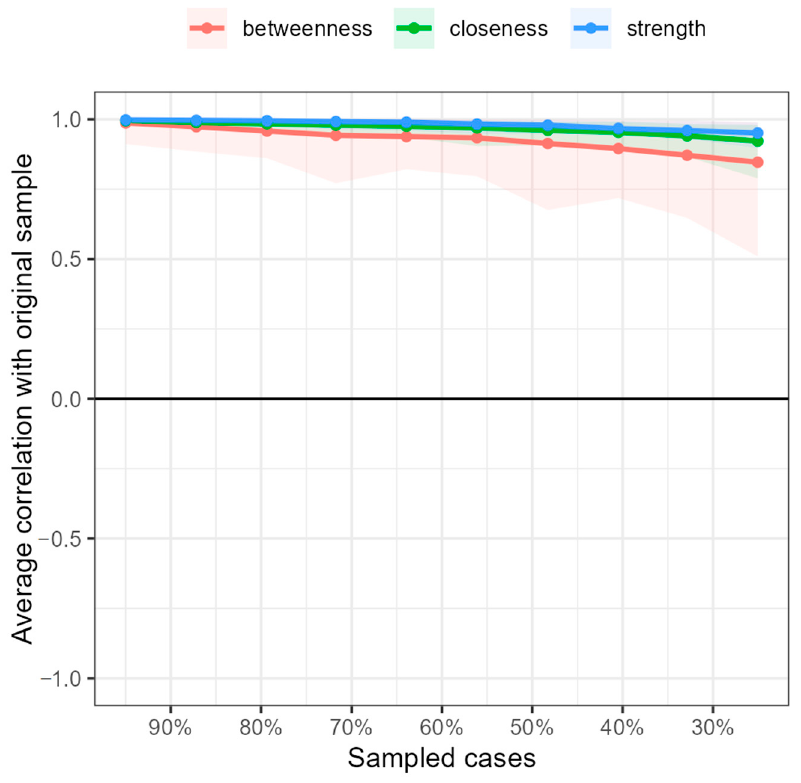
Figure A8. Precision in the estimation of the edges (red line, in the order of the highest to the lowest), and the 95% confidence interval of the estimates (gray line) for the network in the ‘always’ moment, estimated with the non-parametric bootstrap procedure.